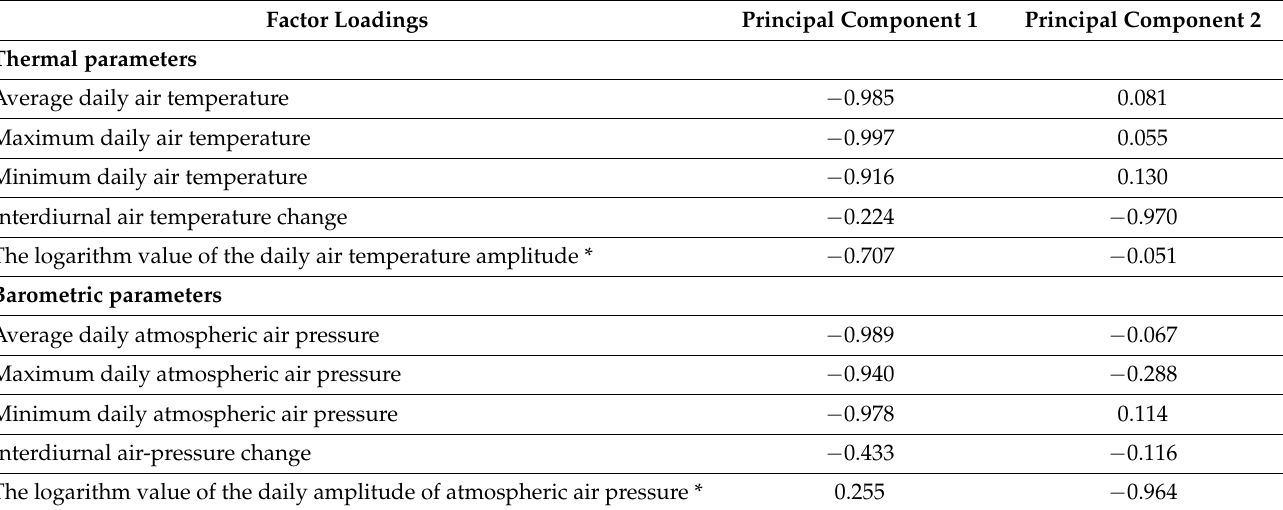
Table 3. Factor loadings for individual thermal and barometric variables in the first two principal components (PCs).